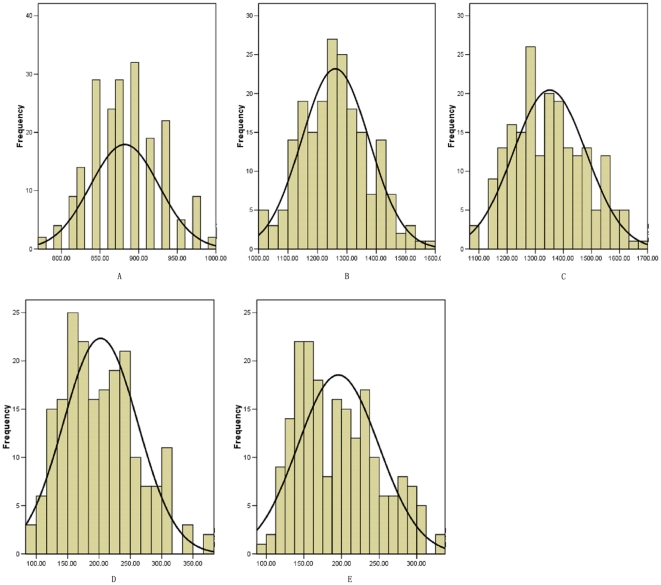
Frequency distribution for flowering time and photoperiod sensitivity in the recombinant inbred lines(RILs) derived from the cross Huangzao4×CML288.(A) flowering time in Sanya (B) flowering time in Henan (C) flowering time in Beijing (D) photoperiod sensitivity in Henan (E) photoperiod sensitivity in Beijing.